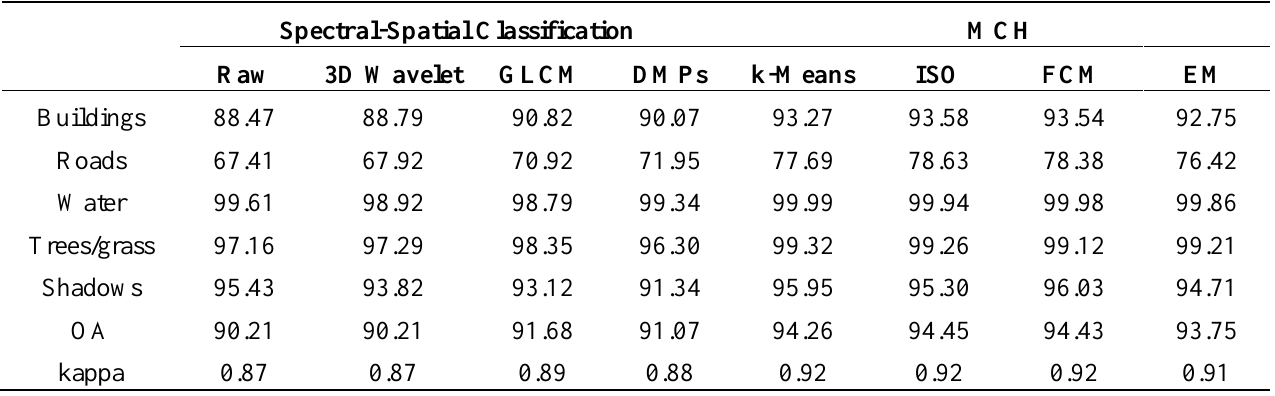
Table 8. Classification accuracies of the different features for the Pavia City image.